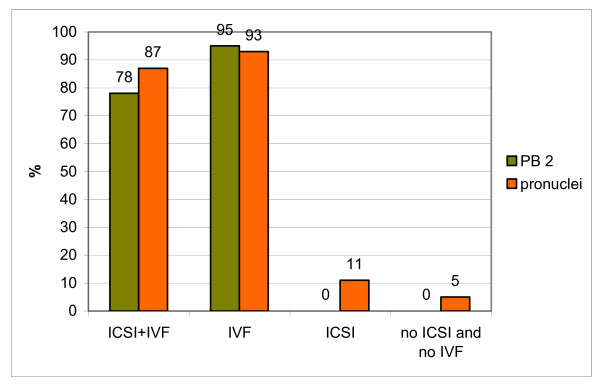
Frequency of the activation of oocytes in different experimental variants. See text for the description of the variants of the experiment. Differences between "ICSI + IVF" and "ICSI" variants, as well as between "IVF" and "no ICSI and no IVF" variants are statistically significant (p < 0.05).